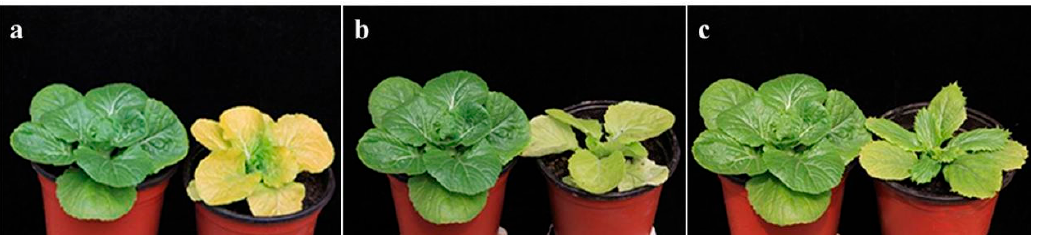
Figure 3. Three leaf color mutants. ( a ) The wild-type ‘FT’ plant (left) and complete leaf etiolation mutant (right); ( b , c ) the wild-type ‘FT’ plant (left) and partial leaf etiolation mutant (right).